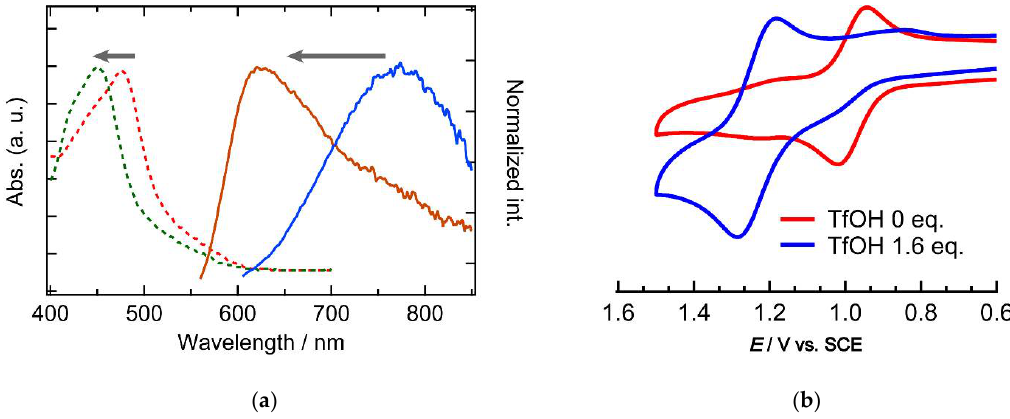
Figure 5. ( a ) Absorption and emission spectra and ( b ) cyclic voltammograms of complex 1 in acetonitrile before and after the addition of 1.6 eq. of TfOH.